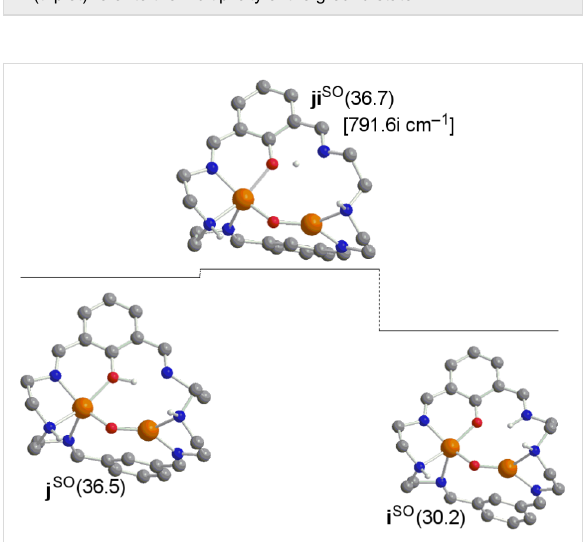
Figure 4: Computed structures for a potential alternative pathway e → g of the σ * mechanism (some H atoms omitted for clarity). Gibbs energies relative to product g (in kcal·mol − 1 ) in solution are given in parentheses. Calculated imaginary frequencies for transition struc- tures are given in brackets. Superindexes SO (open-shell singlet) and T (triplet) refer to the multiplicity of the ground state.